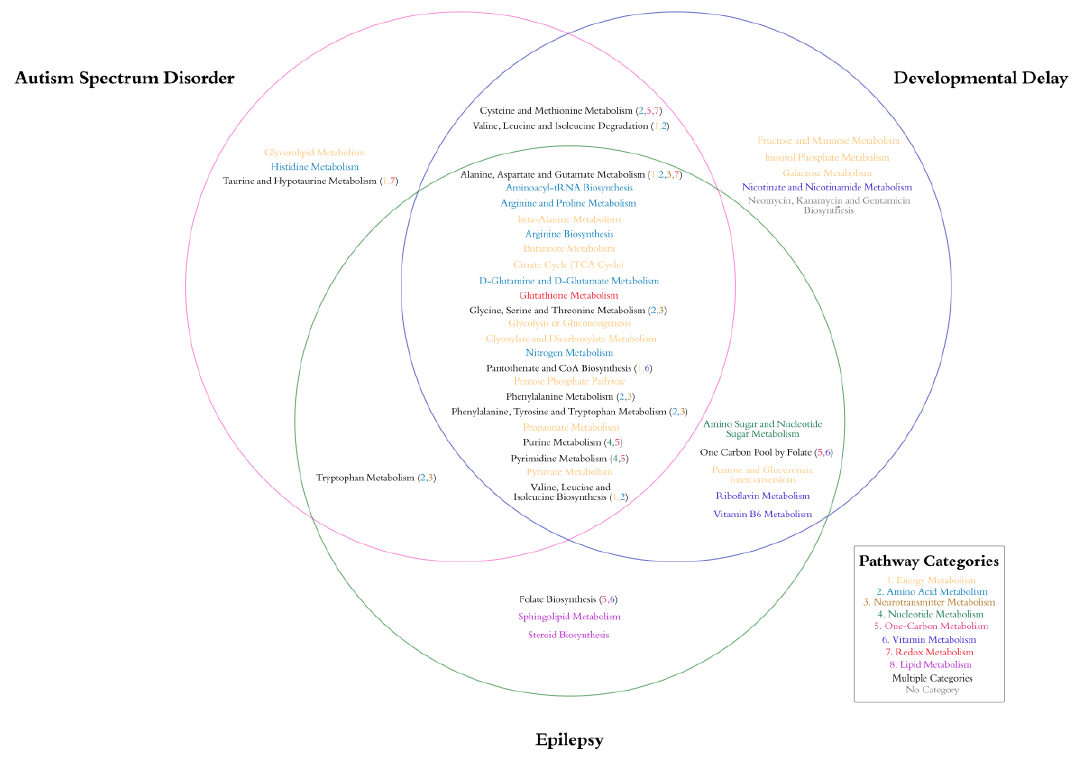
Figure 3. Metabolite–Metabolite Network Pathway Overlap by Clinical Group. Color code represents pathway category. Metabolites in black belong to multiple pathways which are specified by colored numbers in parenthesis following the metabolite name.